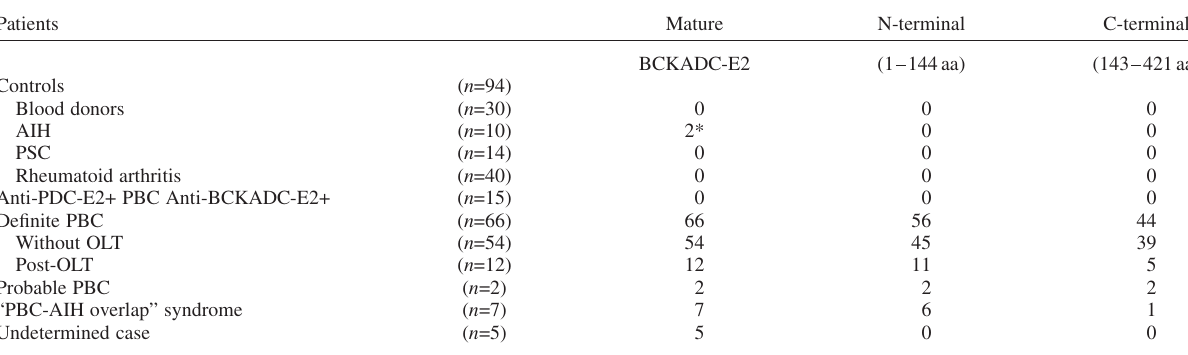
TABLE I Immunoreactivity of sera against BCKADC-E2, N- and C-terminal sequences of the mature protein Patients